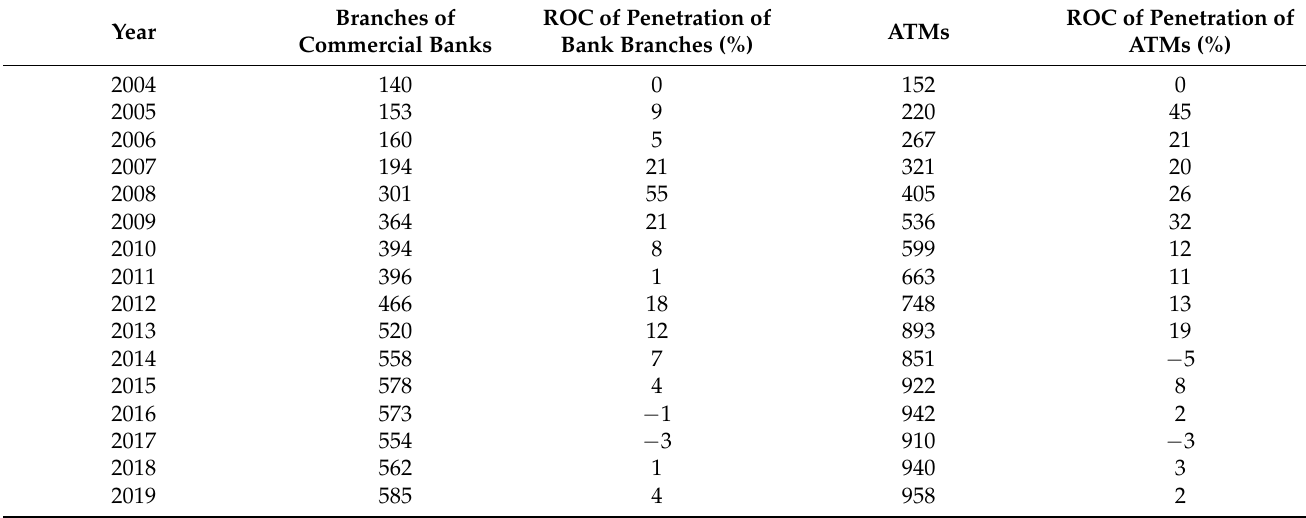
Table 1. Momentum of growth in bank branches and Automated Teller Machines